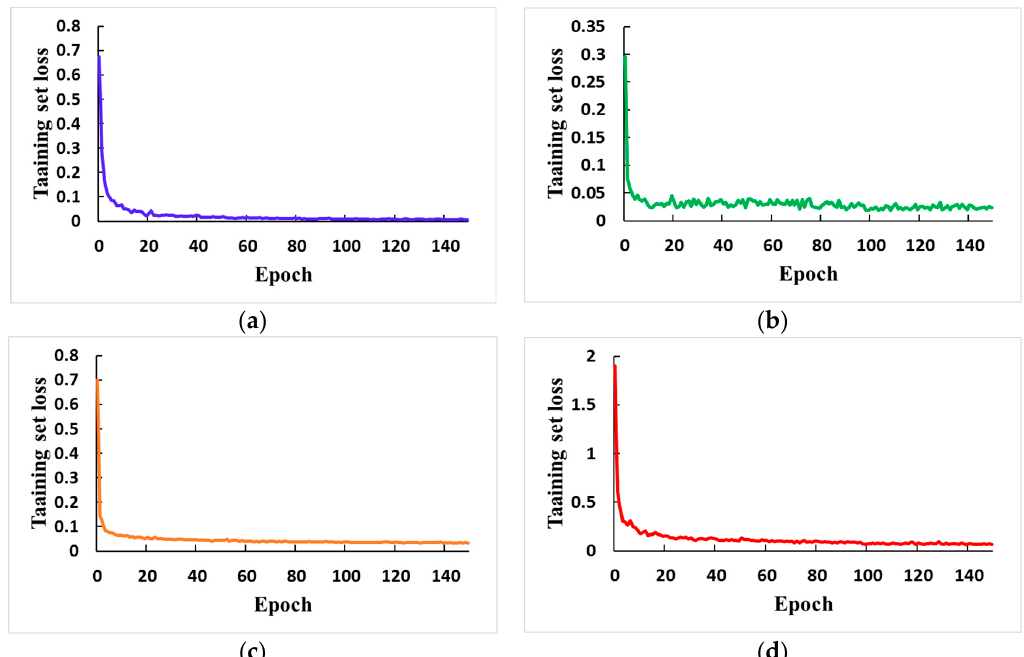
Figure 13. The entire model training process. ( a ) The value of the regression loss function; ( b ) the value of the classification loss function; ( c ) the value of the regression mask loss function; ( d ) the value of the total loss function. Information 2019 , 10 , x FOR PEER REVIEW